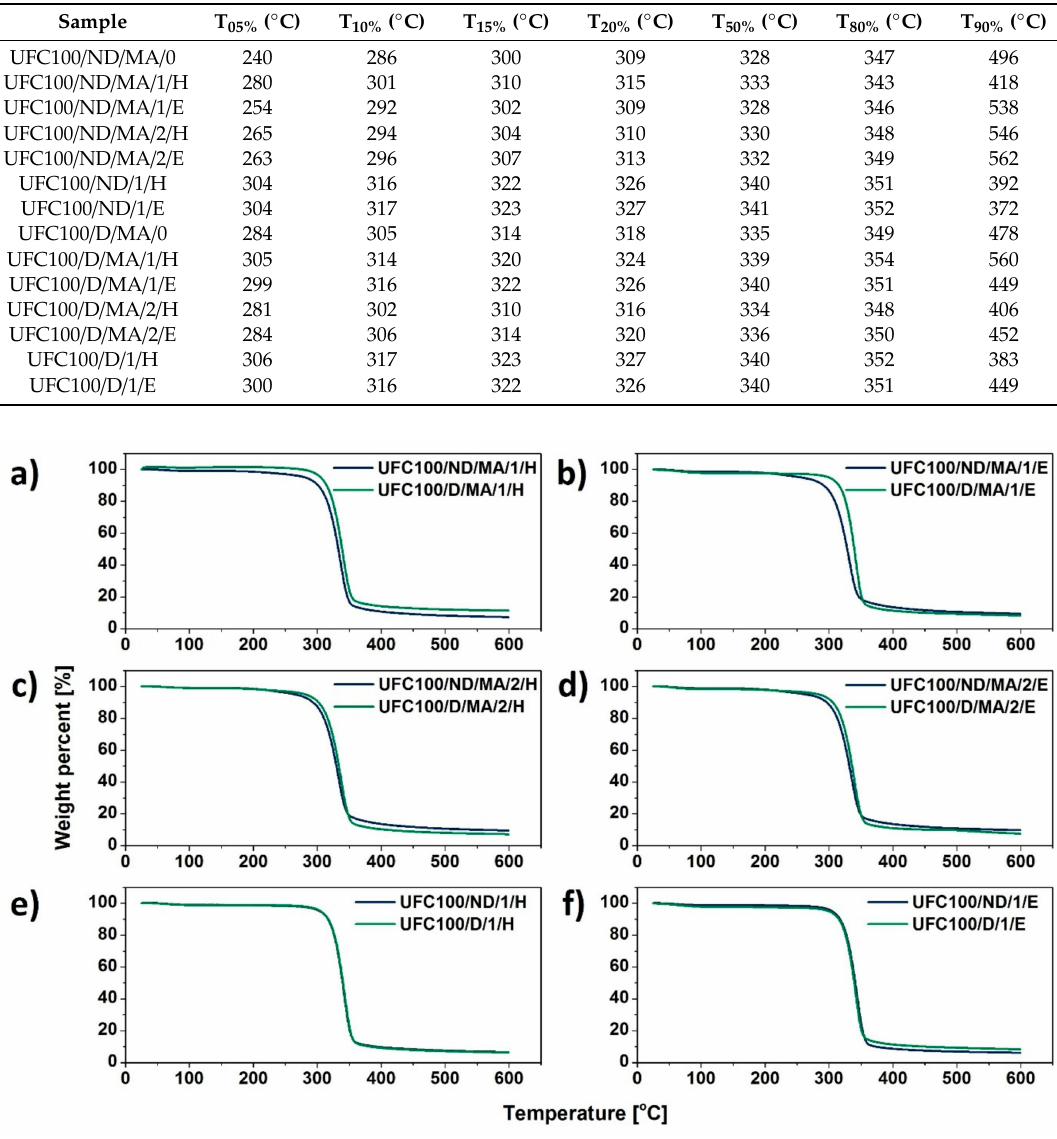
Figure 9. Thermogravimetric analysis (TGA) curves of cellulose samples modified via a hybrid chemical approach and solvent treatment: ( a ) solvent exchanged to hexane and then MA treated, ( b ) solvent exchanged to ethanol and then MA treated, ( c ) MA treated and then solvent exchanged to hexane, ( d ) MA treated and then solvent exchanged to ethanol, ( e ) solvent exchanged to hexane, ( f ) solvent exchanged to